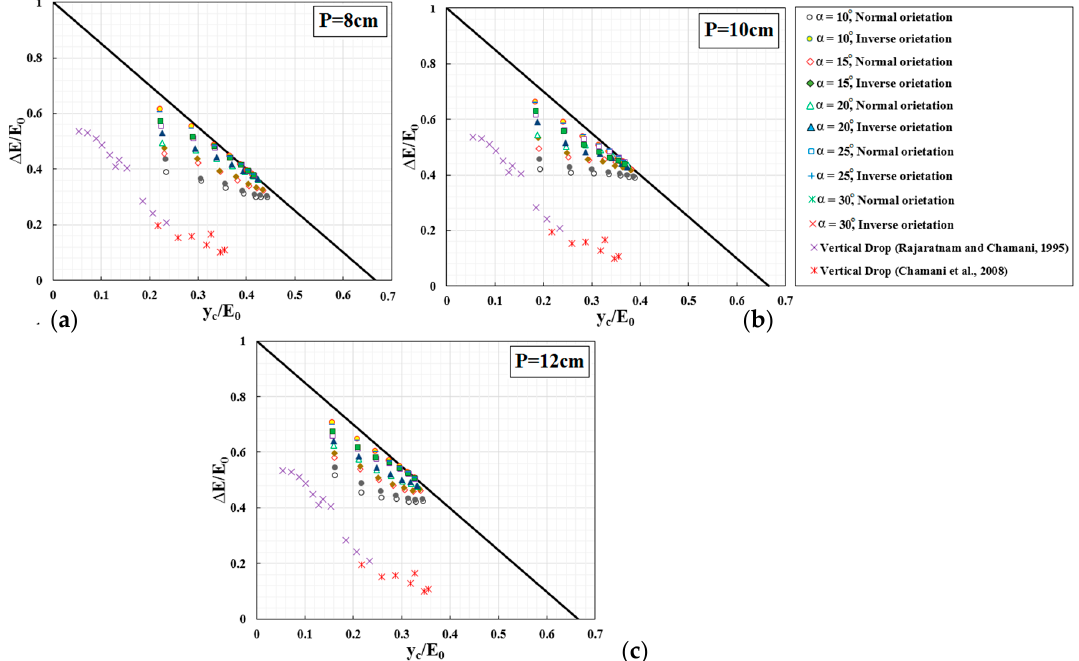
Figure 13. Energy dissipation on TTLW with vertical drop and maximum energy dissipation [31] ( ∆ E / E 0 versus y c / E 0 ), ( a ) P = 8 cm, ( b ) P = 10 cm, ( c ) P = 12 cm.